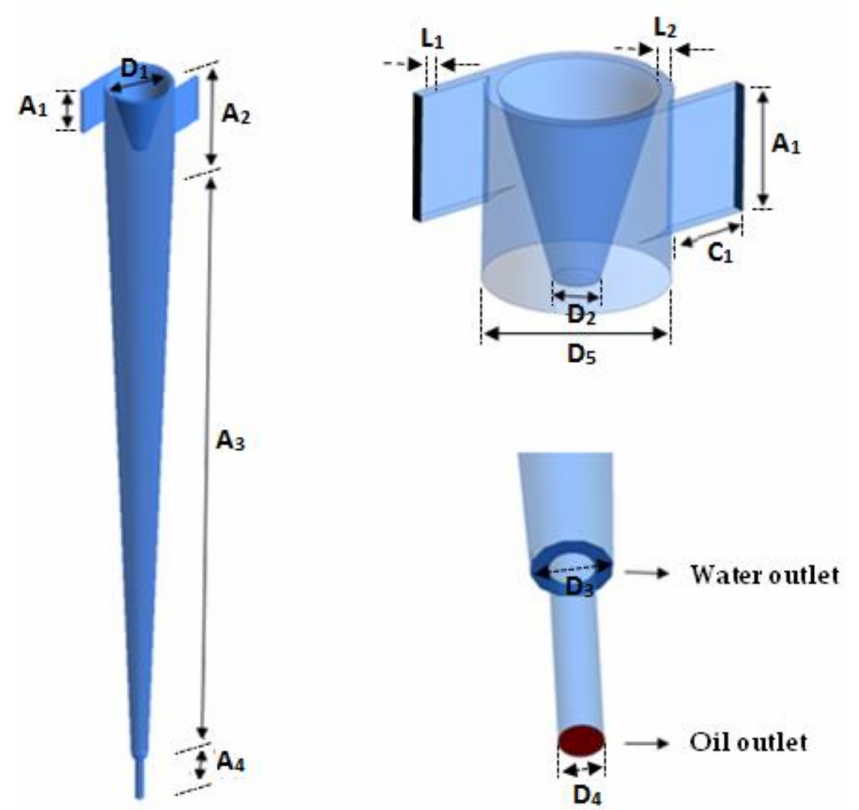
Figure 1. Representation of the cyclonic filter